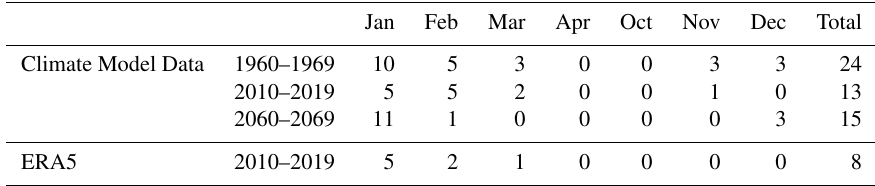
Figure 11. Hourly data of temperature at the control point 2.5mm in depth from the outer side of the wall with southeast orientation and moisture content at the 5mm layer at the outer side of the same wall. The critical temperature, 0 ◦ C, is highlighted with a red line, and the critical moisture content, 77.5kgm − 3 is highlighted with a blue line. The freeze-thaw events are pointed in black boxes. Within the simulations, the indoor air temperature and relative humidity were calculated according to EN 15026. Table 6. Number of freeze-thaw events of a 5mm layer at the exterior side of the southeast-oriented masonry wall. Freezing occurs at a material temperature below 0 ◦ C and a degree of saturation above 0.25. The indoor air temperature and relative humidity were calculated according to EN